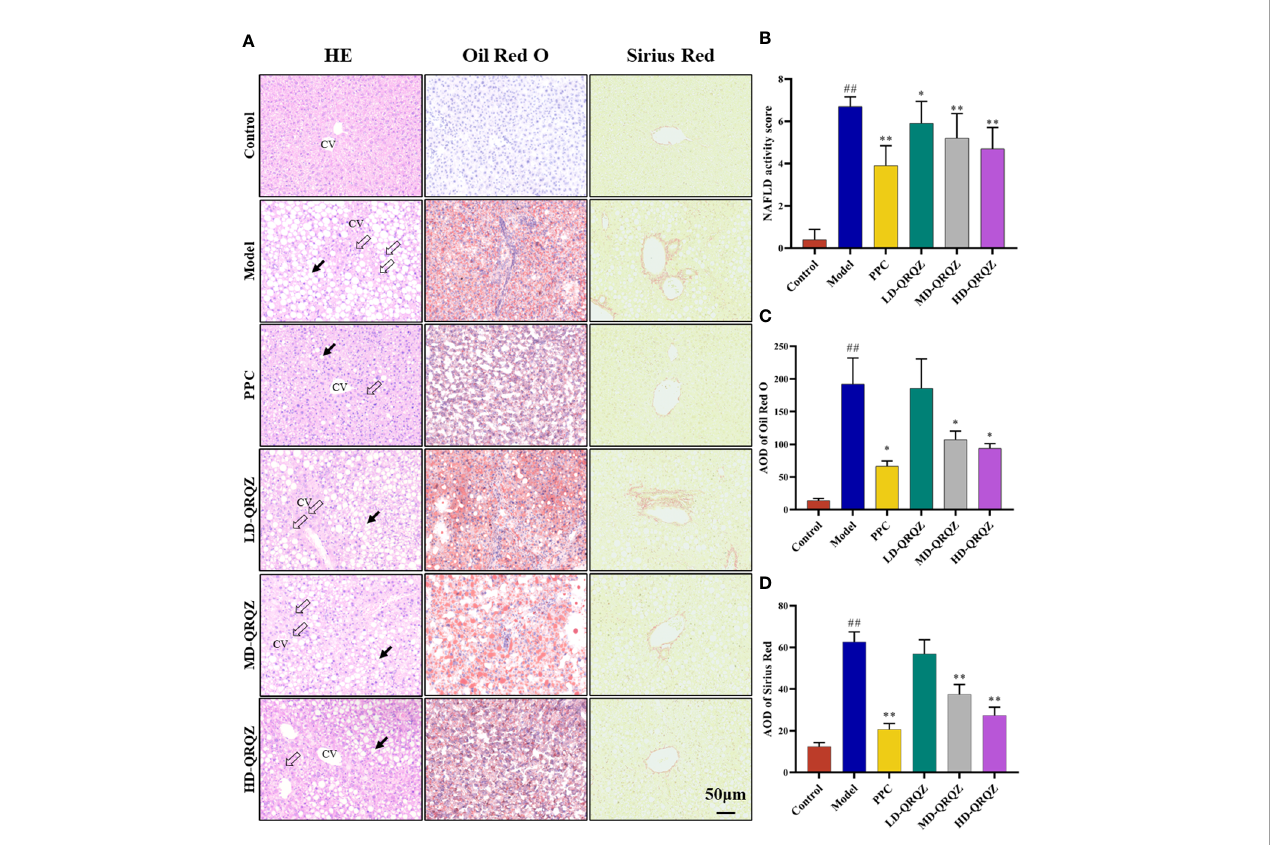
FIGURE 2 QRQZ alleviated hepatic pathological changes in MCD induced NASH mice. (A) HE staining, Oil Red O and Sirius Red staining of liver tissue. Black arrow indicated lipid accumulation. Hollow arrow indicated in fl ammatory foci. CV: Central vein. (200×). (B-D) NAS of HE staining of liver (B) . AOD of Oil Red O (C) and Sirius Red staining (D) . Data are presented as the mean ± standard deviation. ## P < 0.01 as compared to the Control group; * P < 0.05 as compared to the Model group; ** P < 0.01 as compared to the Model